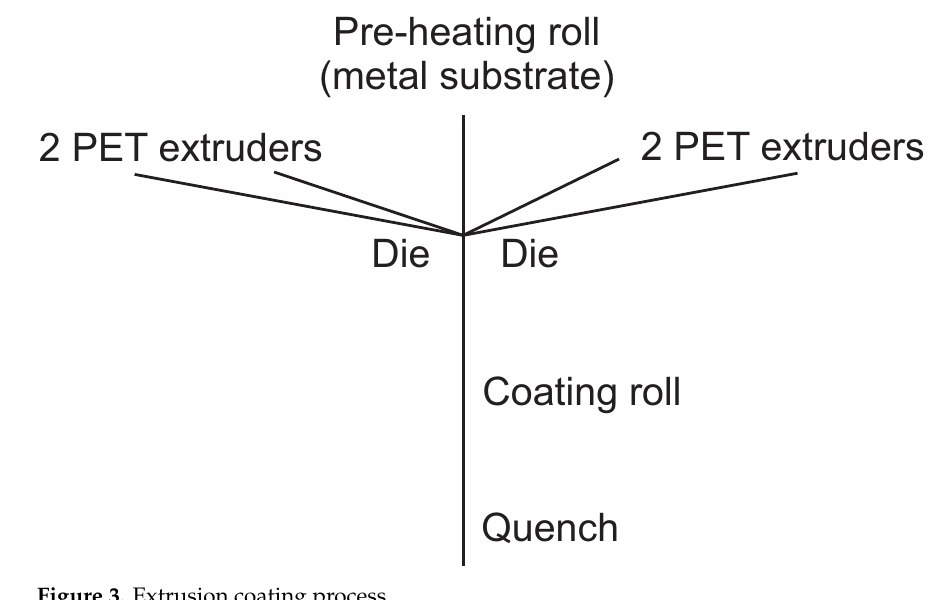
Figure 3. Extrusion coating